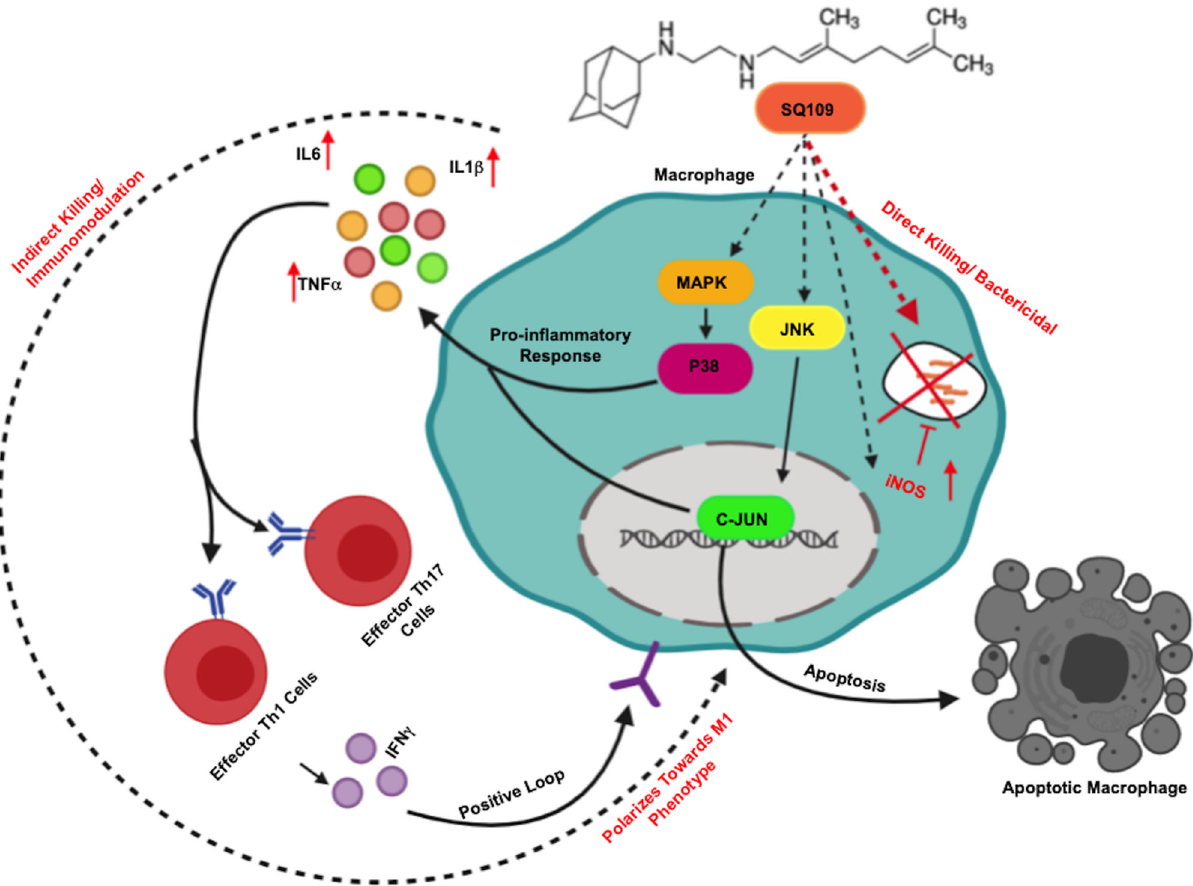
Fig. 5 Proposed mechanism of action of SQ109. SQ109 has a dual mode of action, with direct bactericidal activity and immunomodulatory properties. SQ109 activates the MAPK and JNK pathways in macrophages, leading to the induction of pro-in fl ammatory M1-type macrophage responses and apoptosis. Pro-in fl ammatory responses further modulate the dynamics of T helper cells, which imparts further protection to the host. SQ109 induces production of iNOS, which further mediates the killing of intracellular